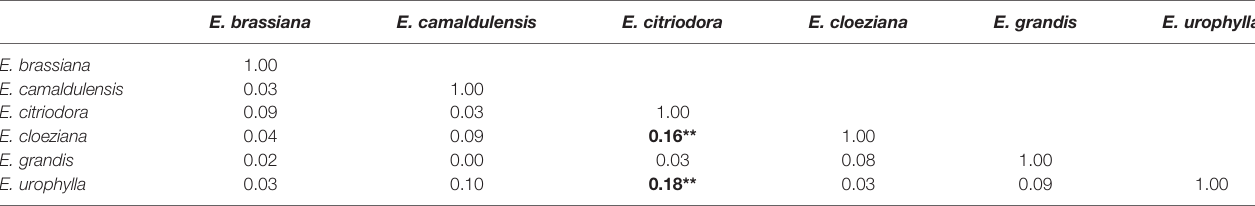
TABLE 3 | R² value obtained by Adonis test among Eucalyptus species using the dissimilarity matrix (Bray-Curtis distance) of the soil fungal community structure obtained by terminal restriction fragment length polymorphism.